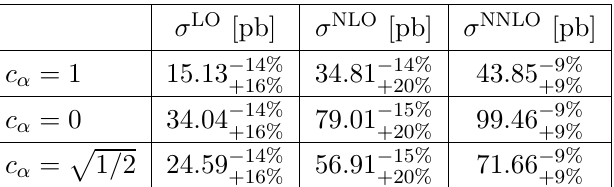
Table 1 . Total inclusive cross sections for Higgs boson production at LO, NLO and NNLO at the 13 TeV LHC, for three values of c (cid:11) . The cross section is shown for the central scale choice (cid:22) = m H = 2. The subscripts (superscripts) indicate the scale variation obtained by varying by a factor of 1/2 (2). See text for further